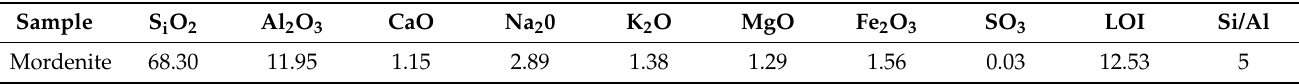
Table 2. Chemical composition (% weight) of the natural mordenite sample used in this research, and determined by XRF. Sample Mordenite